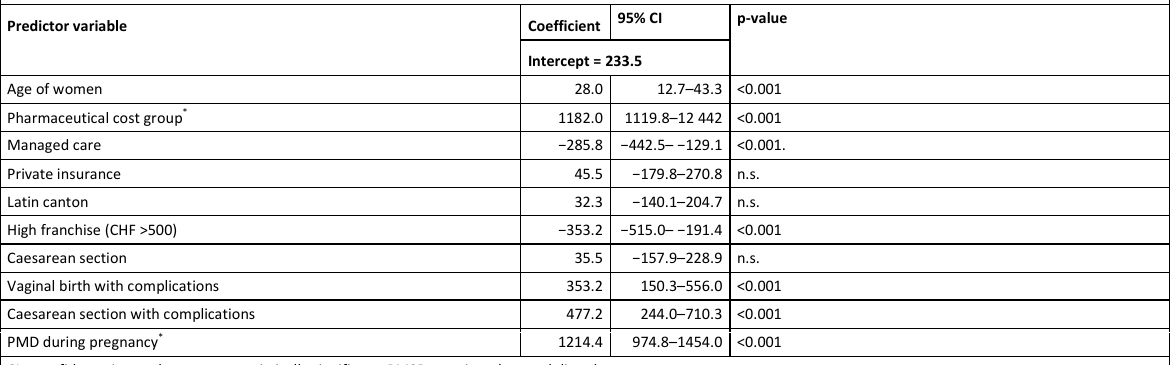
Table 3: Costs of health care in the postpartum year as influenced by perinatal mental disorder during pregnancy and other predictors (Multiple Linear Regression). Predictor variable Coefficient 95% CI p-value Intercept = 233.5